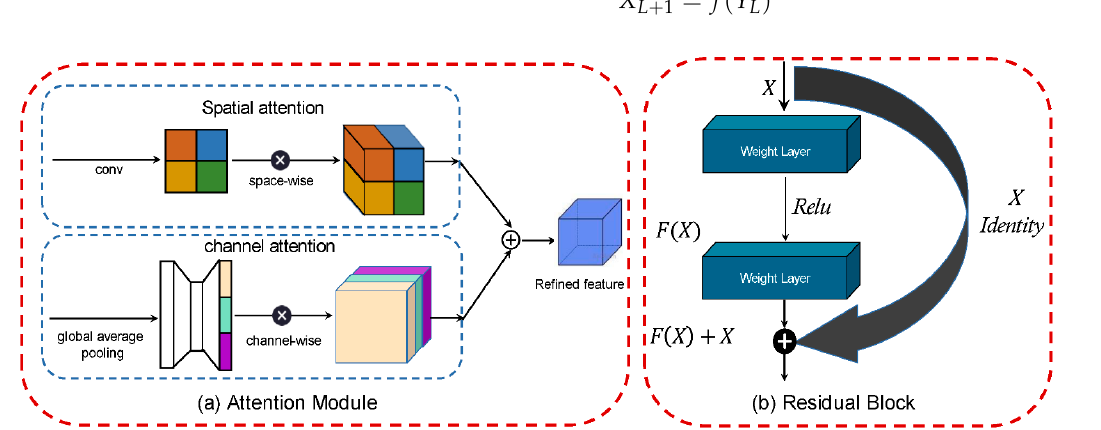
Figure 3. The left part ( a ) is the schematic diagram of spatial attention and channel attention. The right part ( b ) is the schematic diagram of a residual block in the residual network.